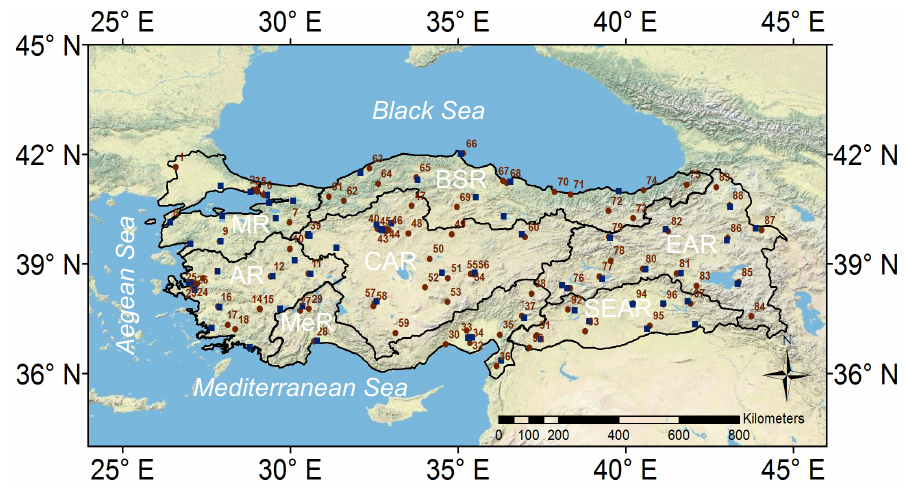
Figure 1. The distribution of PM 10 observations at 97 air quality monitoring stations (brown points) and visibility observations (METARs, blue square) at 64 airports in Turkey. The detail explanations (i.e., geographic coordinates and daily averaged PM 10 values of the stations during the dust storm days) of the numbers of the stations are described in Table 1. The borders of the seven geographic regions with its abbreviated names are also shown in the figure. MR: Marmara Region, AR: Aegean Region, MeR: Mediterranean Region, CAR: Central Anatolian Region, BSR: Black Sea Region, EAR: Eastern Anatolian Region, SEAR: Southeastern Anatolian Region.